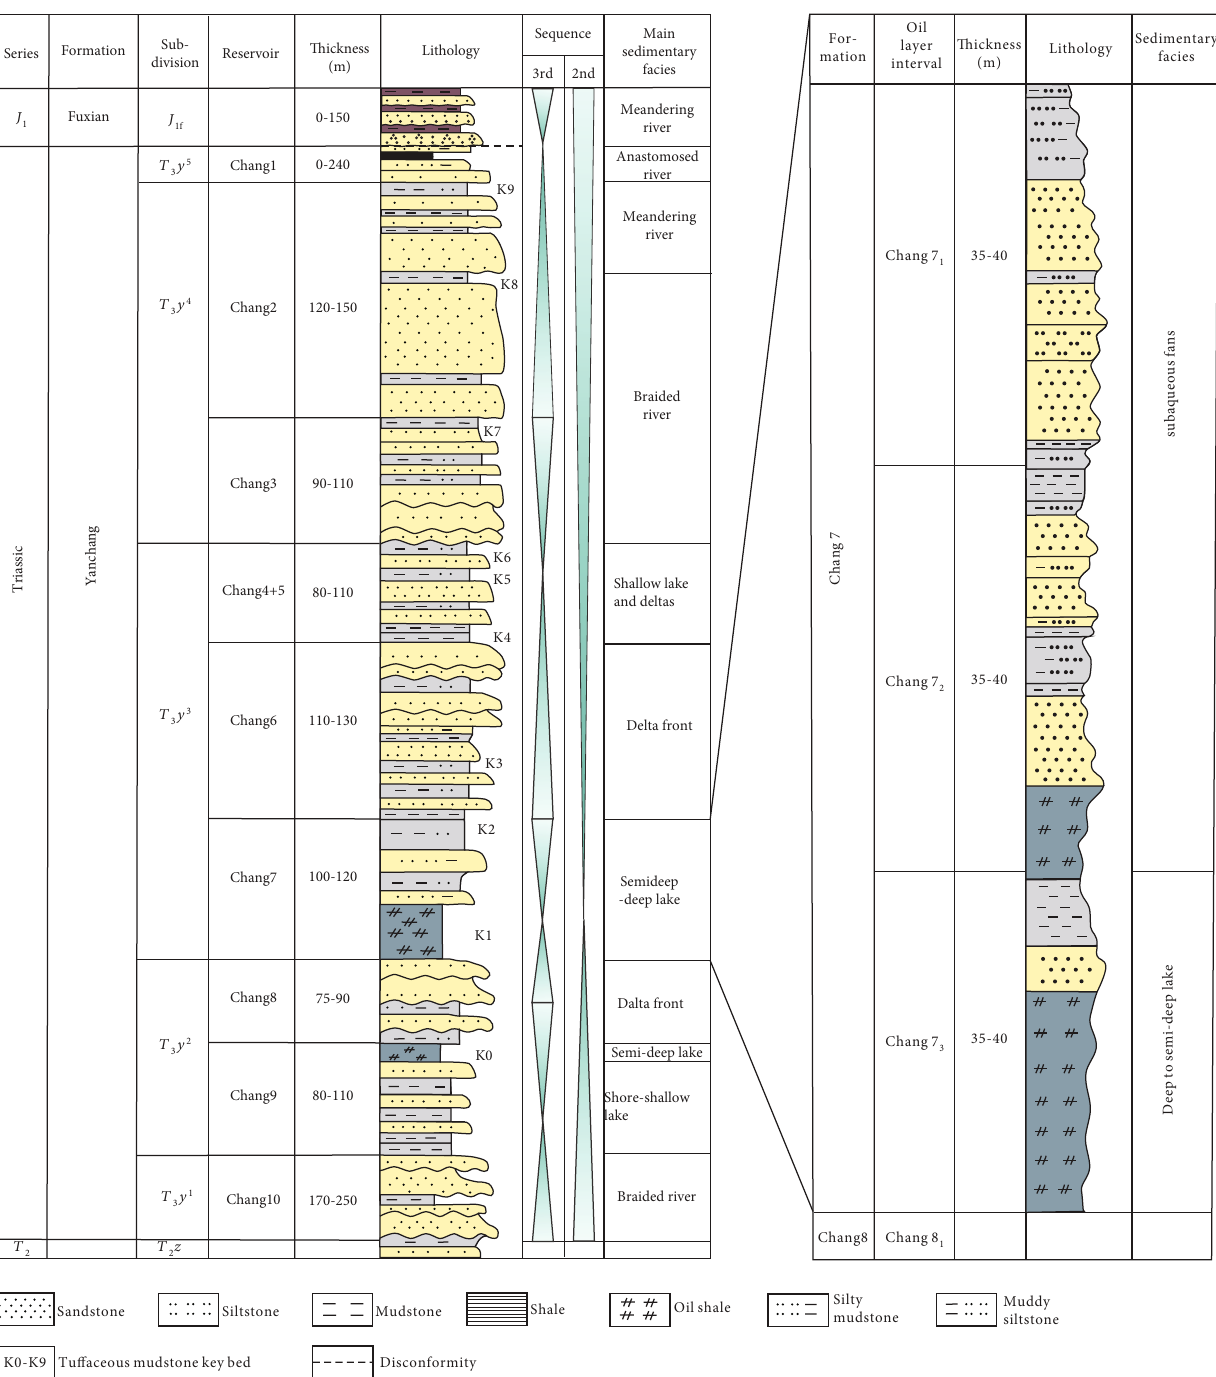
Figure 2: The generalized stratigraphic chart showing lithologies, sedimentary facies, the sequence stratigraphy, and evolution of the Yanchang Fm and Chang 7 interval in the Ordos Basin (the data were referenced from Yanhe outcrop and wells Z526 and